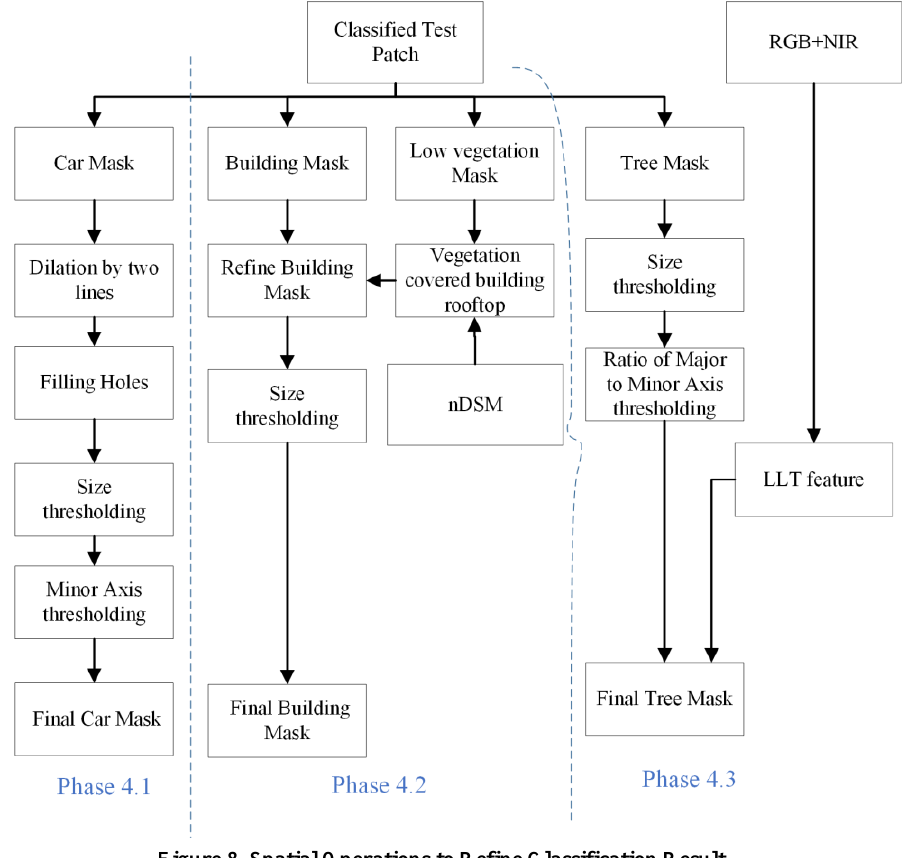
Figure 8. Spatial Operations to Refine Classification Result.